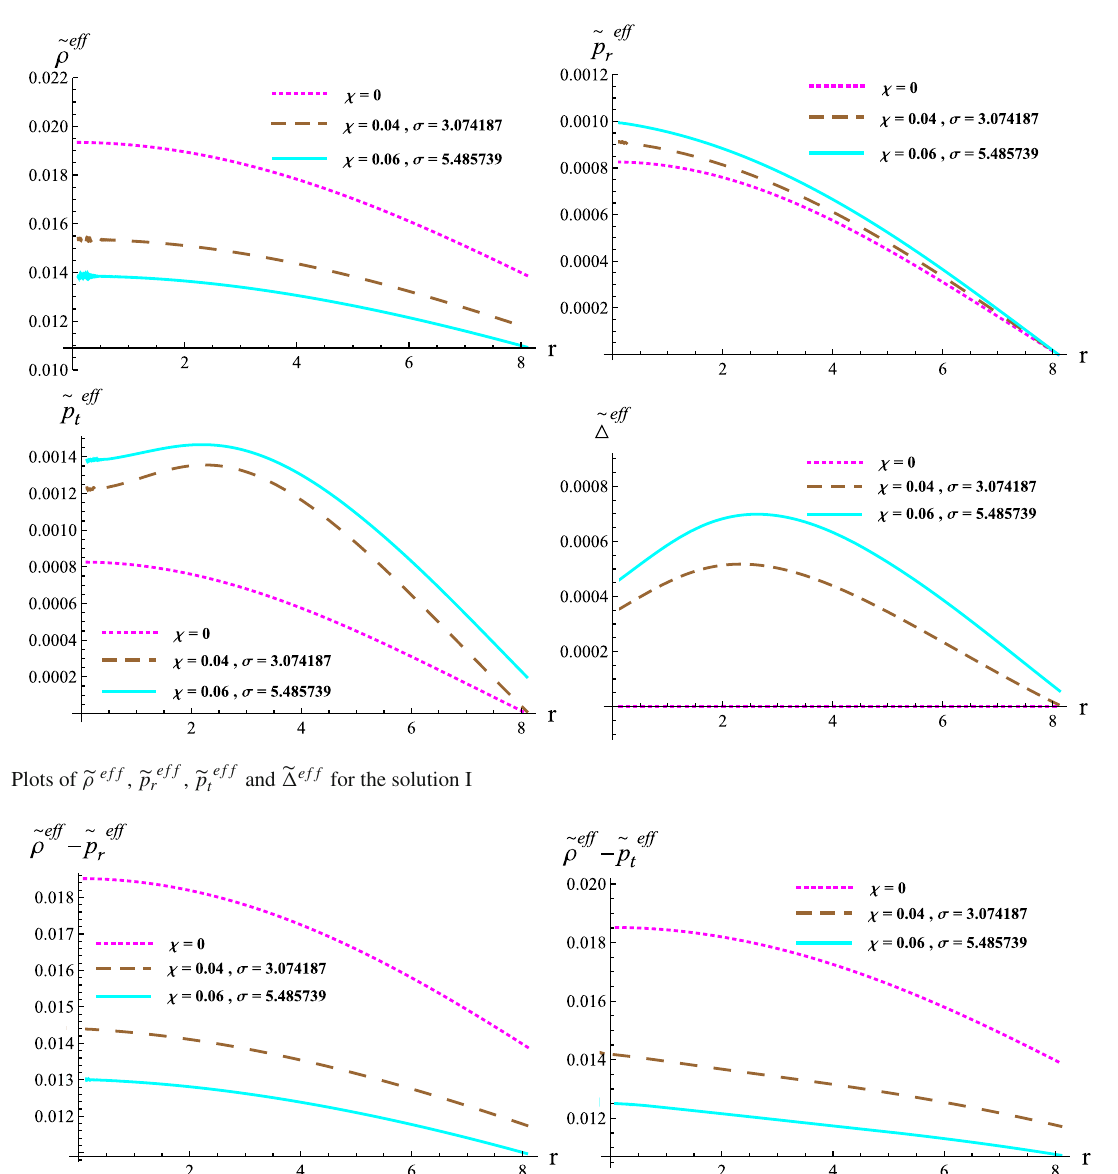
Fig. 2 Plots of (cid:5) ρ ef f − (cid:5) p ef f r and (cid:5) ρ ef f − (cid:5) p ef f